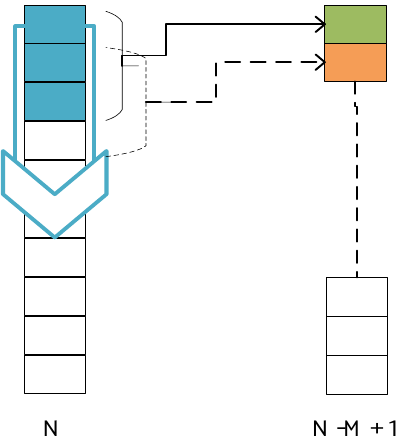
Figure 4. Convolution